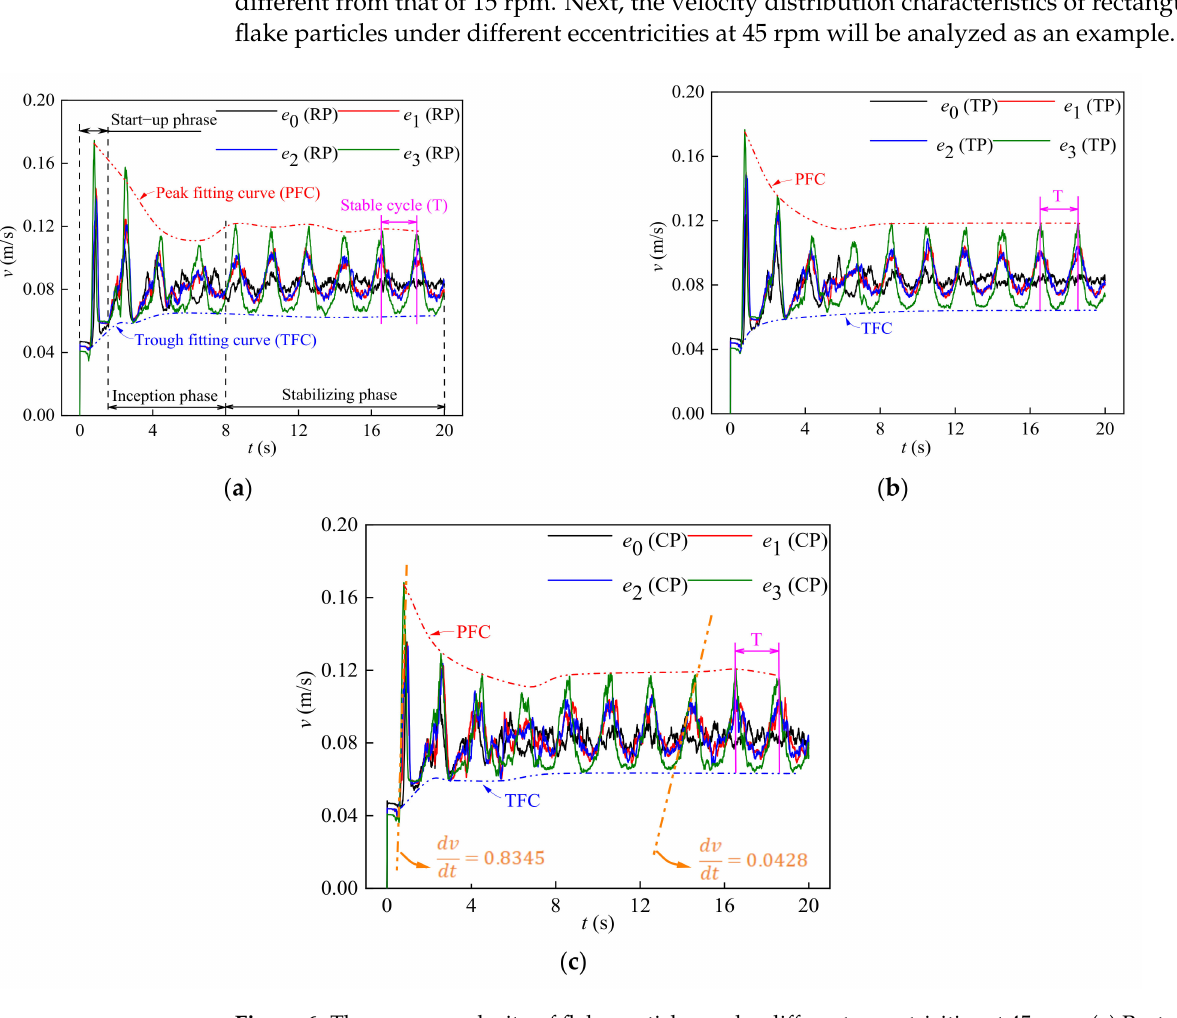
Figure 6. The average velocity of flake particles under different eccentricities at 45 rpm. ( a ) Rectangu- lar flake particles; ( b ) triangular flake particles; ( c ) circular flake